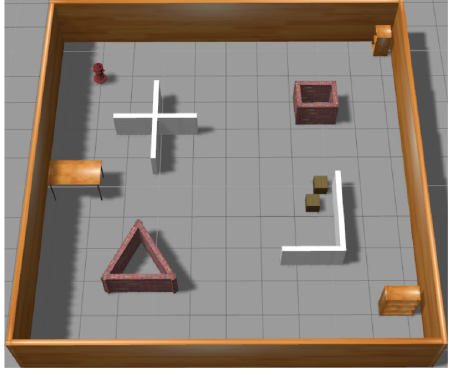
Figure 3. Environment in the Gazebo simulator for training. Table 1. CDDPG network learning parameters during